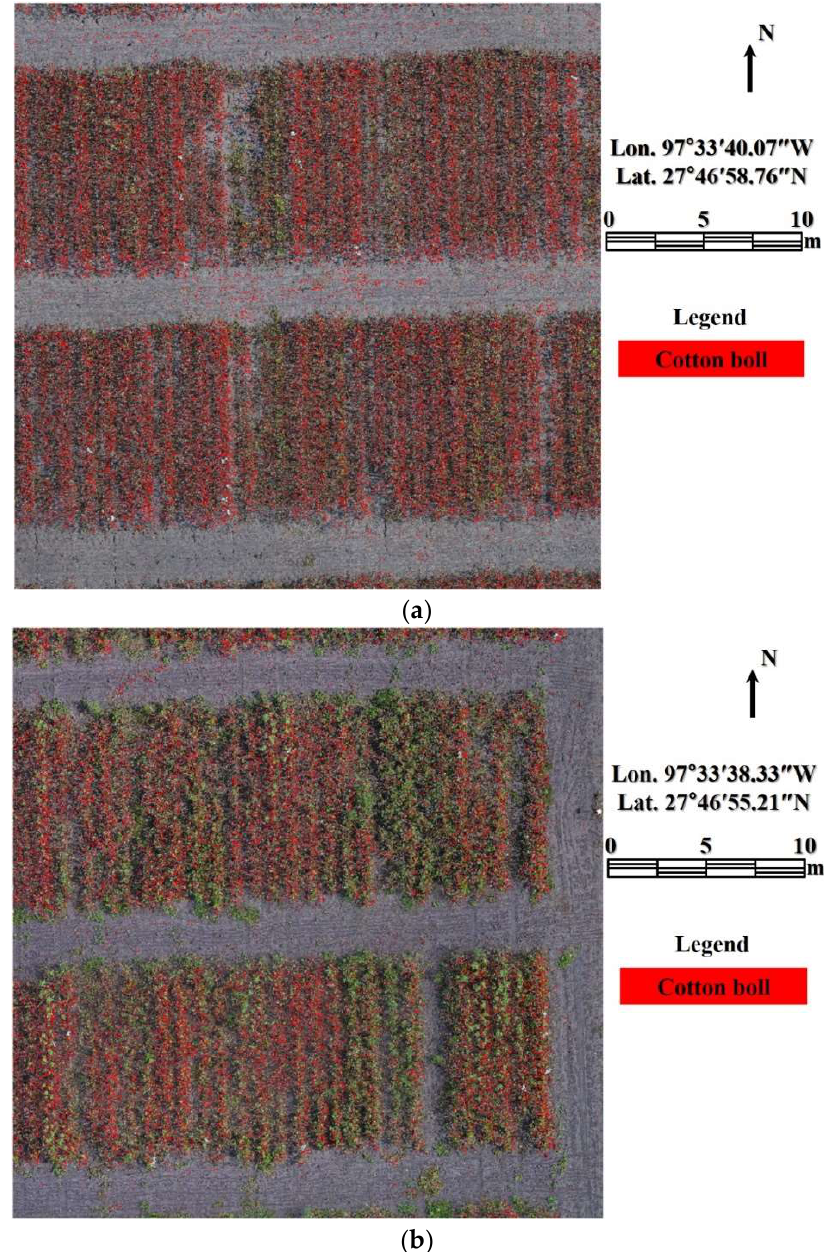
Figure 8. Cotton boll extraction results. ( a ) N3; ( b ) S3 test sites.